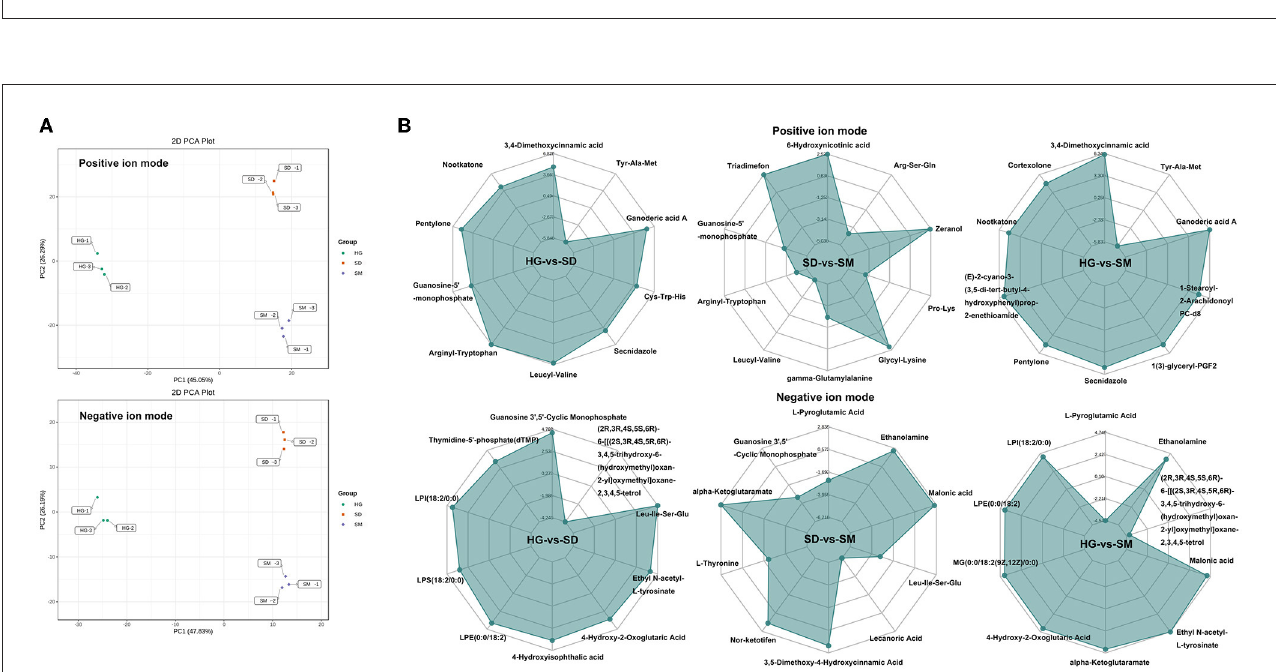
FIGURE3 Gene ontology (GO) and KEGG annotation of the DEGs. (A) The most enriched GO terms of DEGs in the three compared groups. (B) The most enriched KEGG terms of DEGs in the three compared groups.